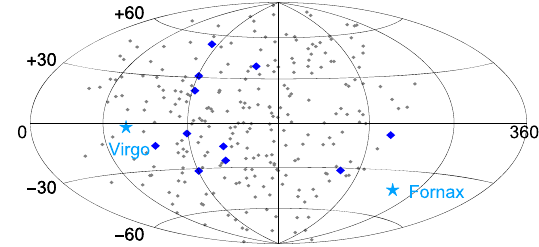
Fig. 2 Arrival directions of HiRes stereo UHE air showers correlated with BL Lac type objects (blue diamonds) together with directions of other showers in the sample (gray dots) in the celestial sphere (super- galactic coordinates)